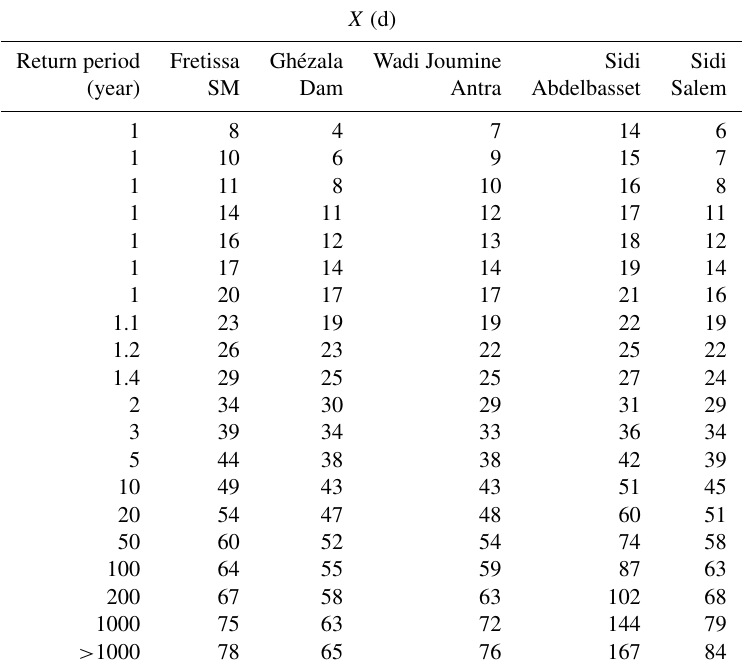
Table 6. Return period (years) for Ichkeul lake basin based on the maximum annual period of dry spell during the growing